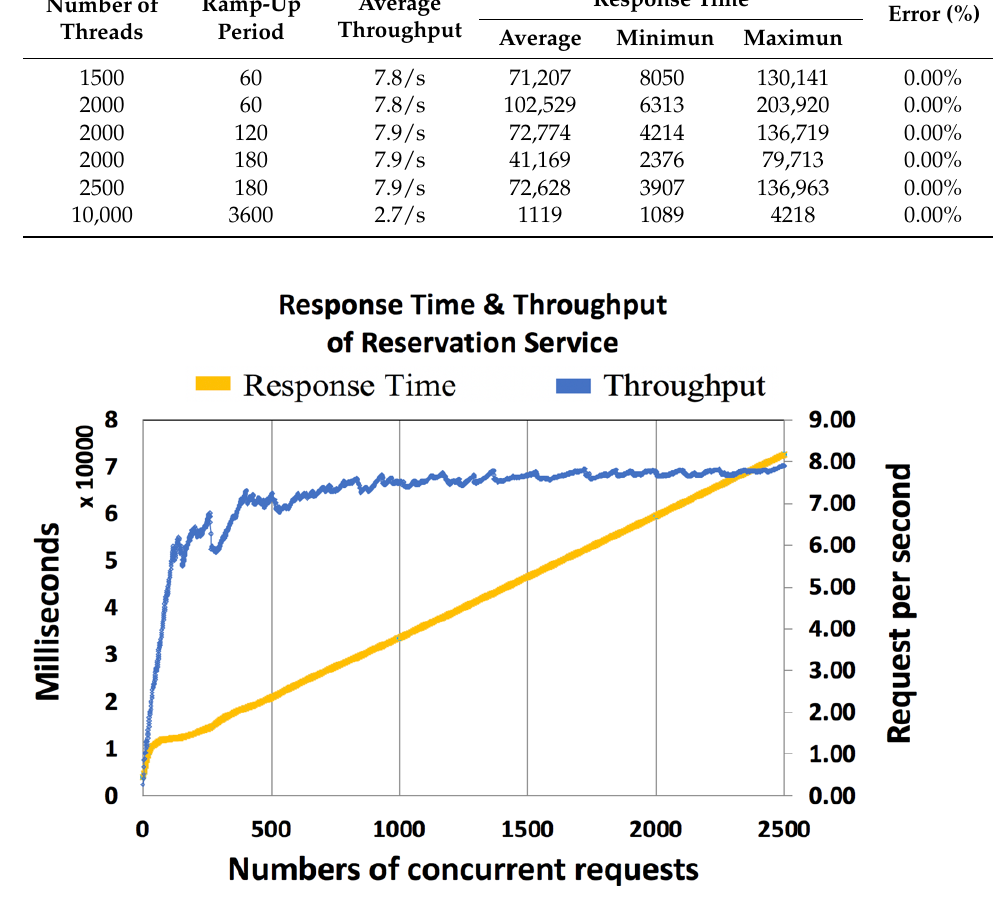
Figure 29. Throughput and response time of the reservation service behavior for 3 min.